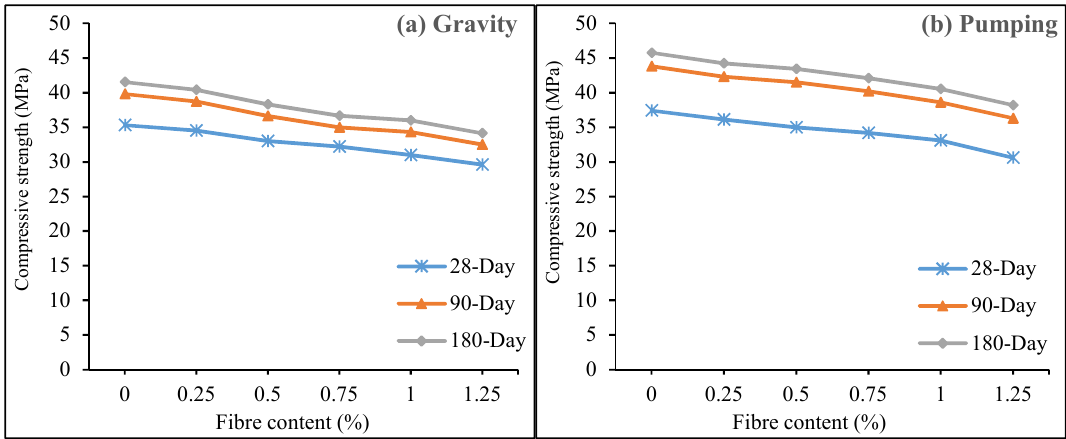
Figure 6. Variation in the compressive strength of ( a ) gravity and ( b ) pumping method PAFRC specimens.